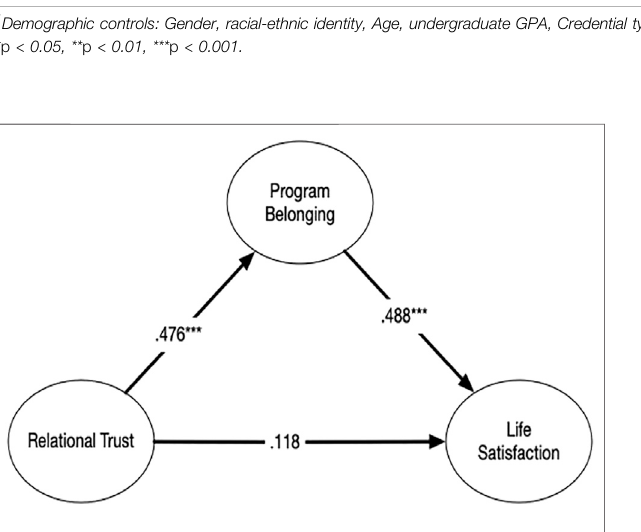
Program sense of belonging